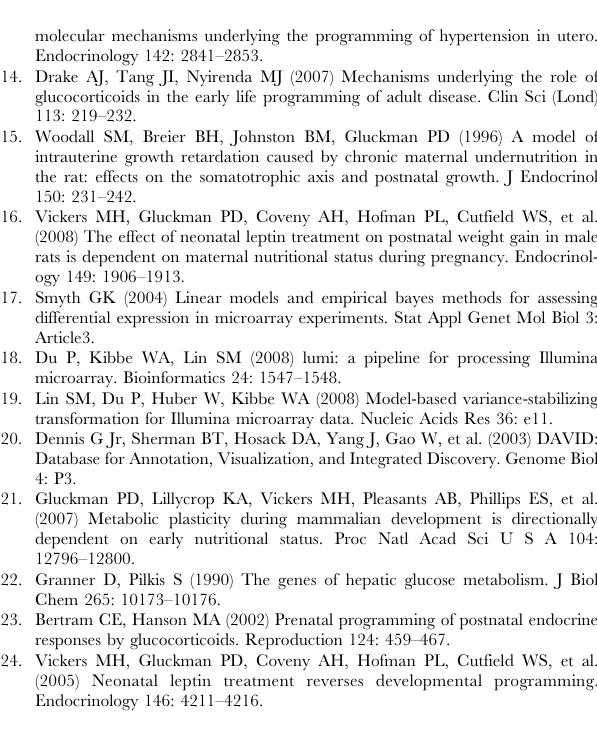
Table S1 PCR primer sequences used for the qRT-PCR analysis Table S2 Raw data for all Illumina Array Data after filtering and normaization including annotation